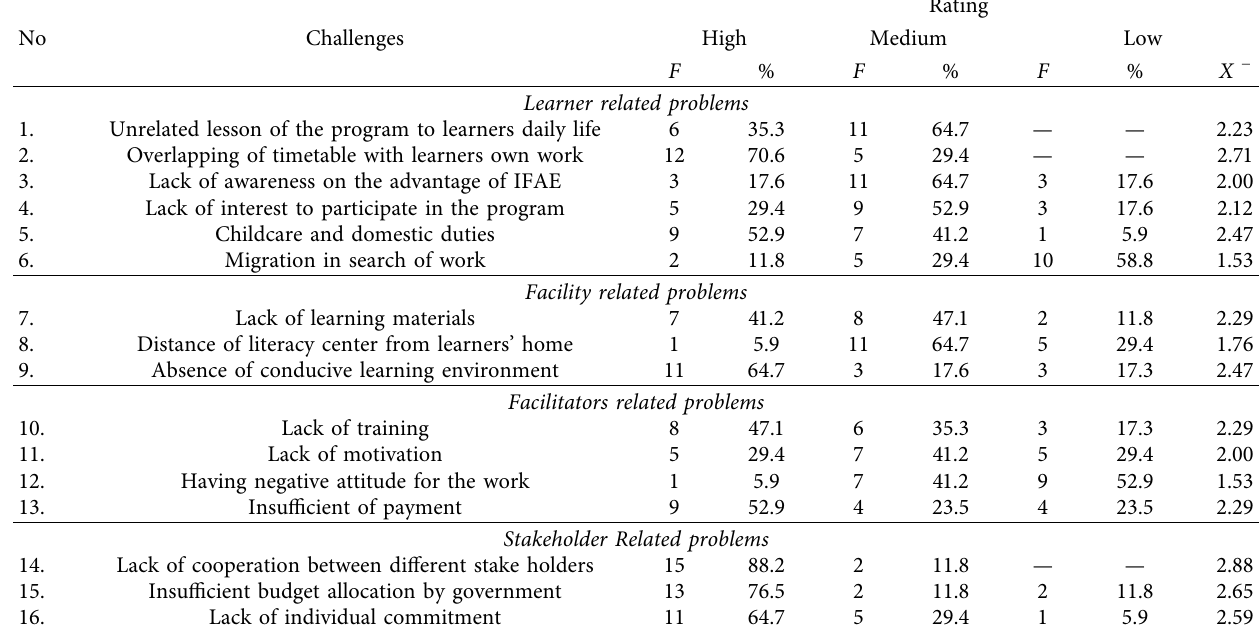
Table 3: Facilitator’s response to challenges of the IFAE program